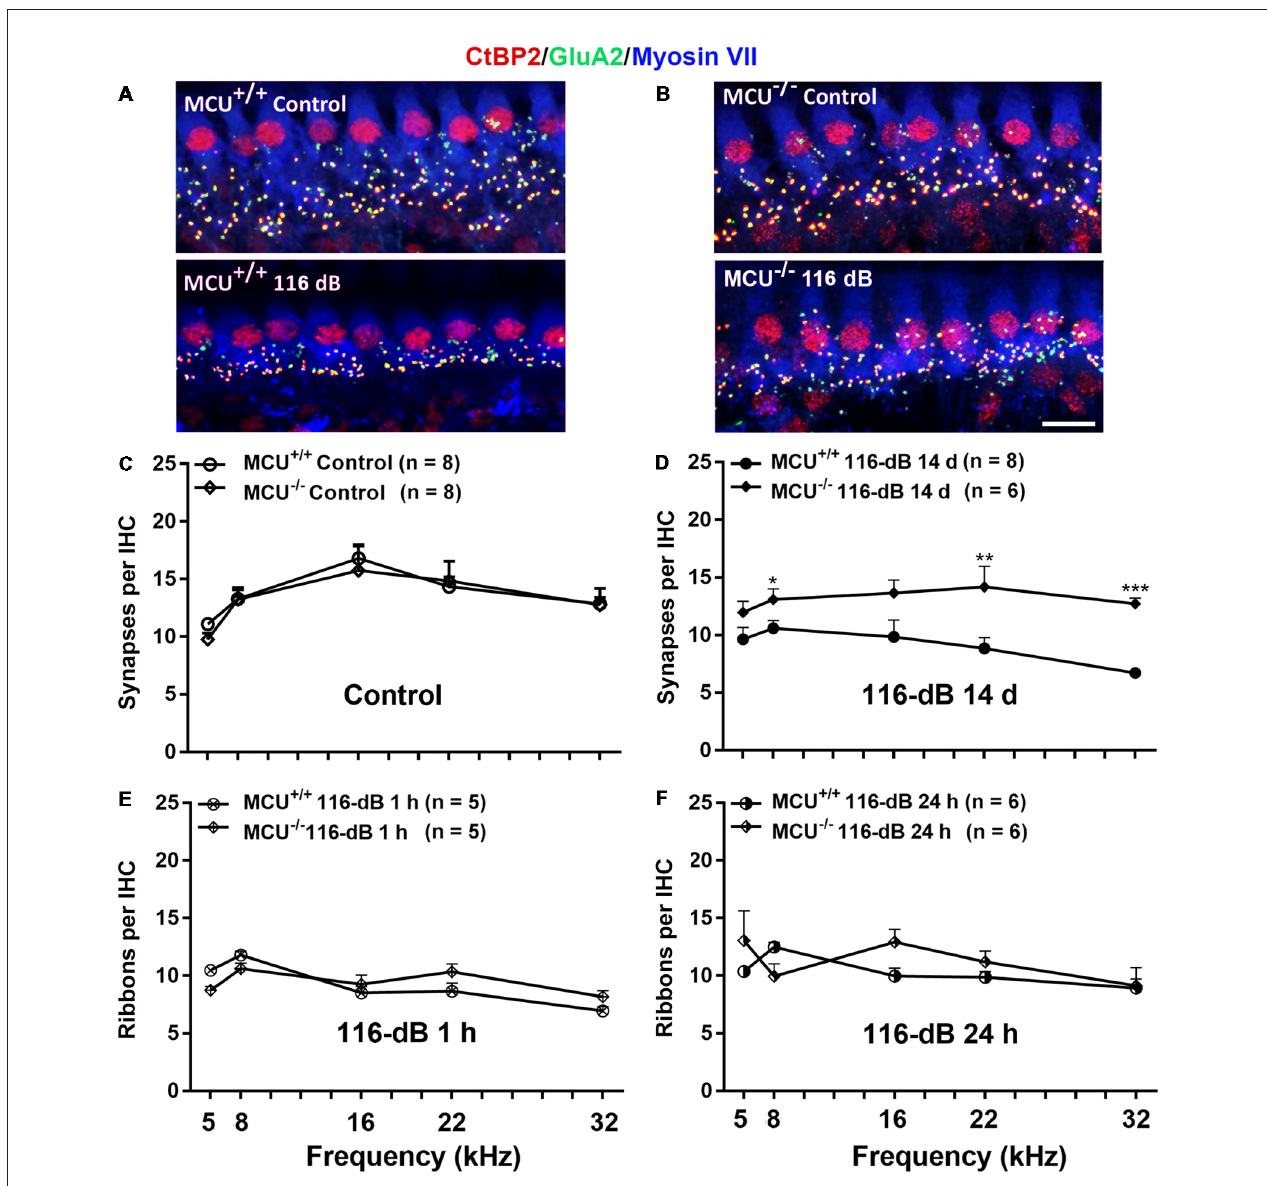
FIGURE 7 | Noise-induced losses of synapses were attenuated in MCU knockout mice at 14 days after the completion of noise exposure. (A,B) Representative images of immunolabeling for IHC synapses in the apical region corresponding to 8 kHz of MCU + / + or MCU − / − mice examined 14 days after the noise exposure. The images were projected from Z sections. Red: CtBP2, green: GluA2, blue: myosin-VIIa-labeled IHCs; scale bar = 10 µ m. (C) The number of synapses per IHC was similar between MCU + / + and MCU − / − mice without noise exposure. (D) The number of synapses had recovered significantly in MCU knockout mice but not in littermates when examined 14 days after the noise exposure. (E) Noise-induced loss of ribbons was also similar between MCU − / − mice and littermates when examined 1 h after the completion of noise exposure. (F) Ribbons were not different between MCU − / − mice and MCU + / + when examined 24 h after the completion of noise exposure. Data are shown as means ± SEM in panels (C–F) , n indicates the number of mice with one cochlea used per mouse, ∗ p < 0.05, ∗∗ p < 0.01, ∗∗∗ p <